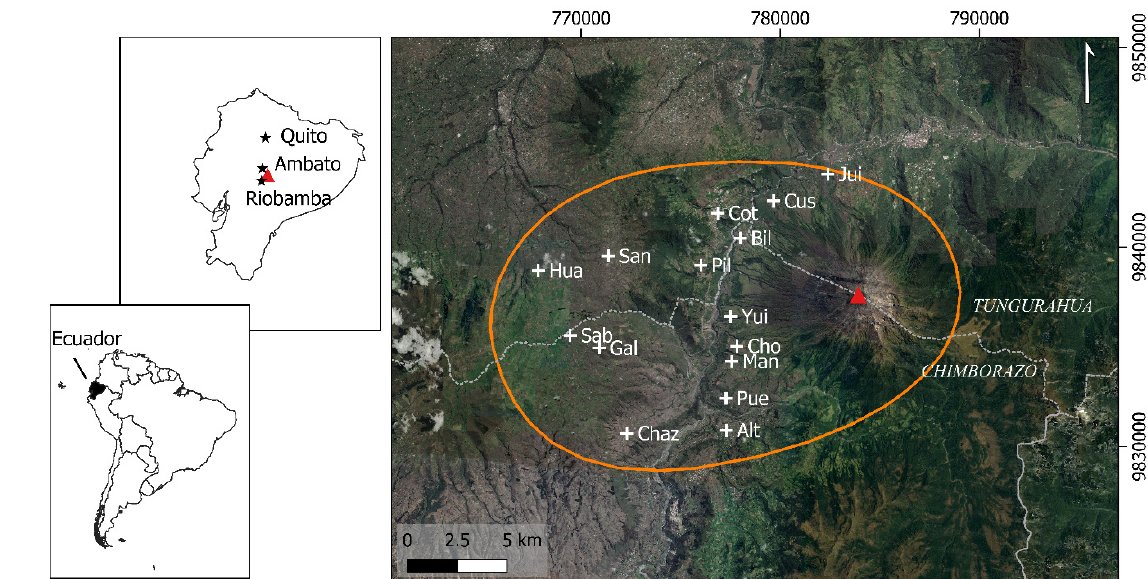
Figure 1: Location map. Inset shows location of Tungurahua volcano in Ecuador. The orange line delineates the study area (see text for explanations). White crosses represent the 15 villages surveyed: Jui:Juive Grande; Cus: Cusúa; Bil: Bilbao; Yui: Yuibug; Cho: Choglontus; Man: El Manzano; Pue: Puela; Alt: El Altar; Cot: Cotaló; Pil: Pillate; Hua: Hualcanga; Sab: Sabañag; Gal: Santa Fe de Galán; Cha: San José del Chazo: San: Sanctuario. The dashed white line shows the limit between Tungurahua and Chimborazo provinces. The red triangle indicates Tungurahua